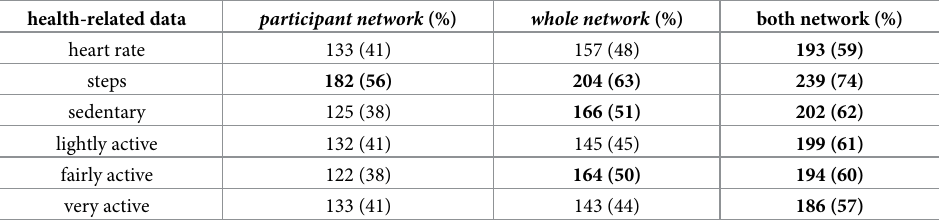
Table 5. Summary of subjects with medium to strong correlation to the social network